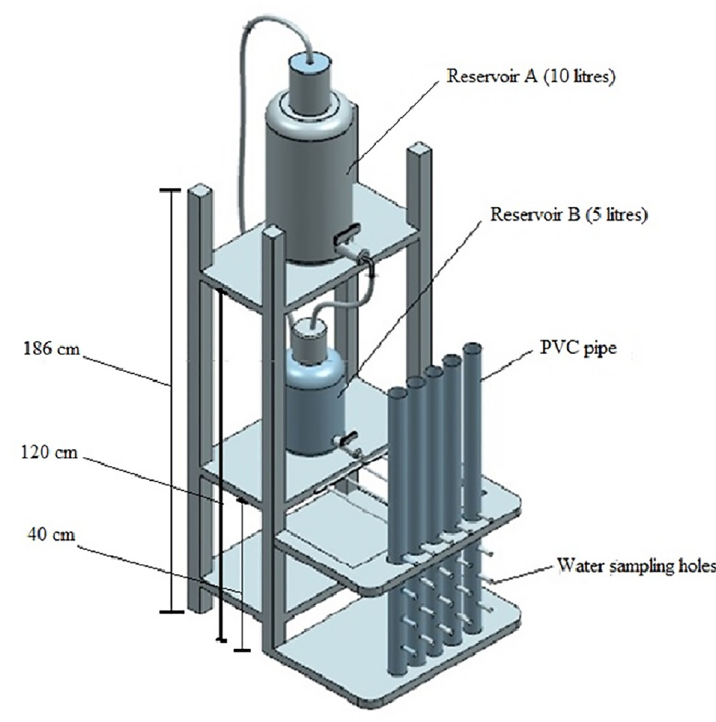
Fig 2. A schematic diagram of the laboratory experiment set up (not drawn into